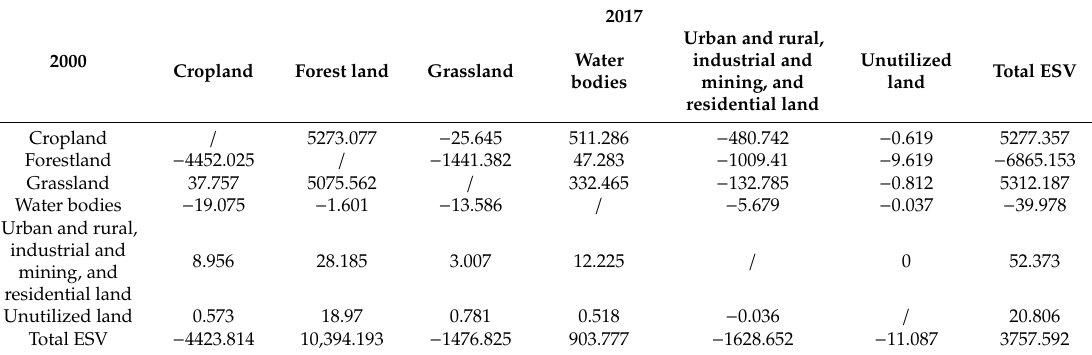
Table 2. Gains and losses matrix of ESVs (unit: 10 6 Yuan